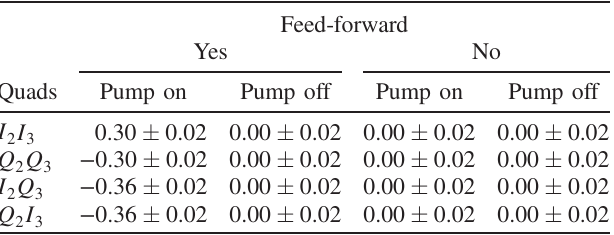
TABLE II. The resultant two-mode correlation coefficient (normalized covariance) between mode 2 and mode 3 after applying correlation feed-forward to the three-mode trisqueezed state (see Fig. 6). As shown, we recover a significant amount of correlation when applying our feed-forward correction. We include the results of applying the protocol to the system noise with the pump off to verify that the protocol itself does not introduce spurious correlations.